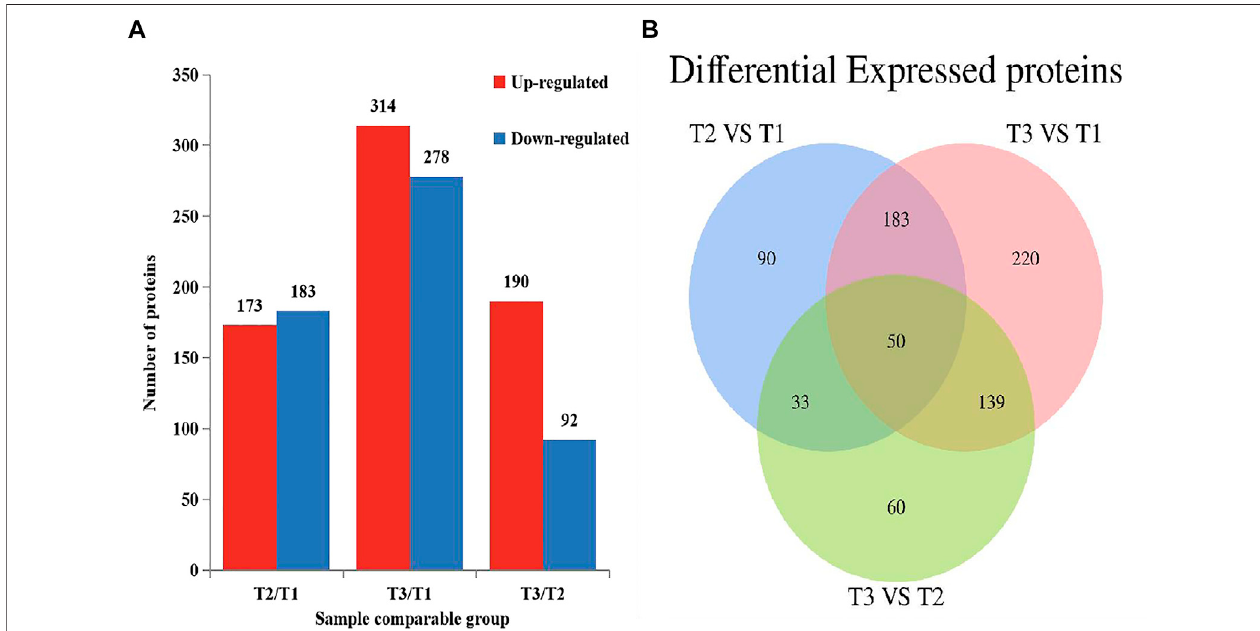
FIGURE 3 | Differential expressed proteins in three comparison groups ( p < 0.05, |fold change| > 1.3). (A) The number of DEPs. (B) Venn diagram of DEPs in Zhongwei goat skin at three developmental stages.